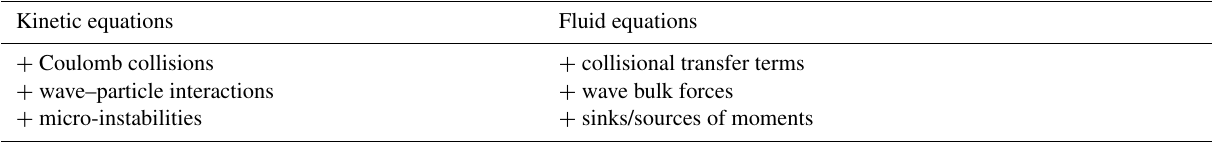
Table 1. Theoretical description of the solar wind in terms of particle distribution functions or their velocity moments. Kinetic equations